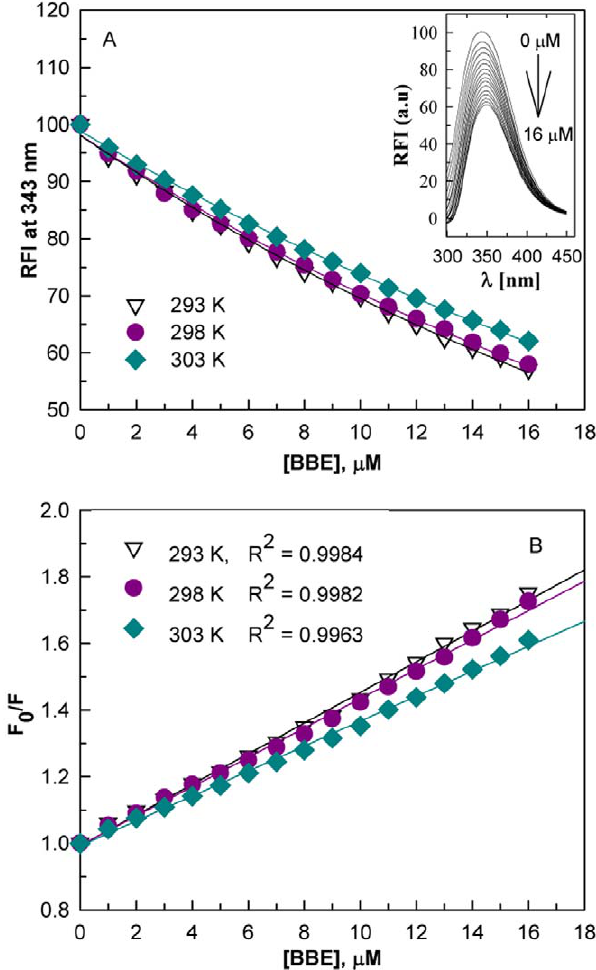
Figure 2. 1,2-Bis(2-Benzimidazolyl)-1,2-Ethanediol (BBE) in- duced fluorescence quenching mechanism of bovine serum albumin. The BBE induced intrinsic fluorescence quenching (A) and Stern-Volmer plots for fluorescence quenching data (B) of BSA at different temperatures. The inset of Figure A shows fluorescence spectra of BSA in the absence and presence of increasing BBE concentrations at 298 K. The concentration of BSA was 5 m M and the intrinsic fluorescence of the protein was measured in 60 mM sodium phosphate buffer of pH 7.4 upon excitation at 280 nm.